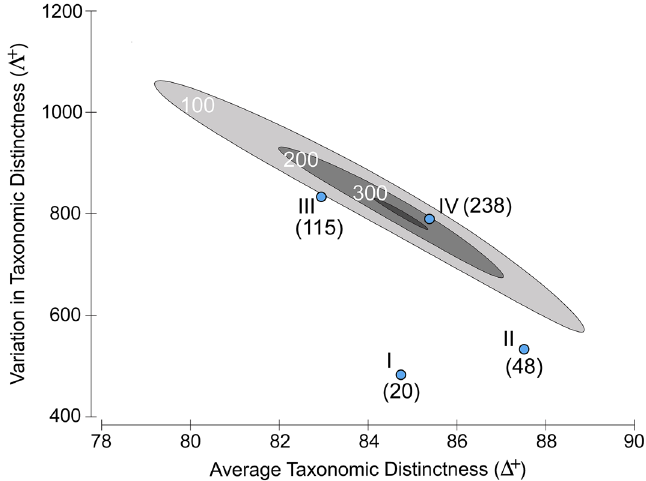
Figure 4. Δ + values of parasite assemblages recorded in each period (I = 1817–1866, II = 1867–1916, III = 1917– 1966, and IV = 1967–2016) plotted against the corresponding value of Λ + . Numbers in brackets indicated the total number of parasites in each period. The relevant 95% probability contours (ellipse) for ( Δ + , Λ + ) paired values obtained from 1,000 independent simulations from the full list of parasites were also plotted. Ellipse was built for random subsets of 300 (dark grey), 200 (grey), and 100 (light grey) species. Analysis was done using the software package PRIMER v6 70